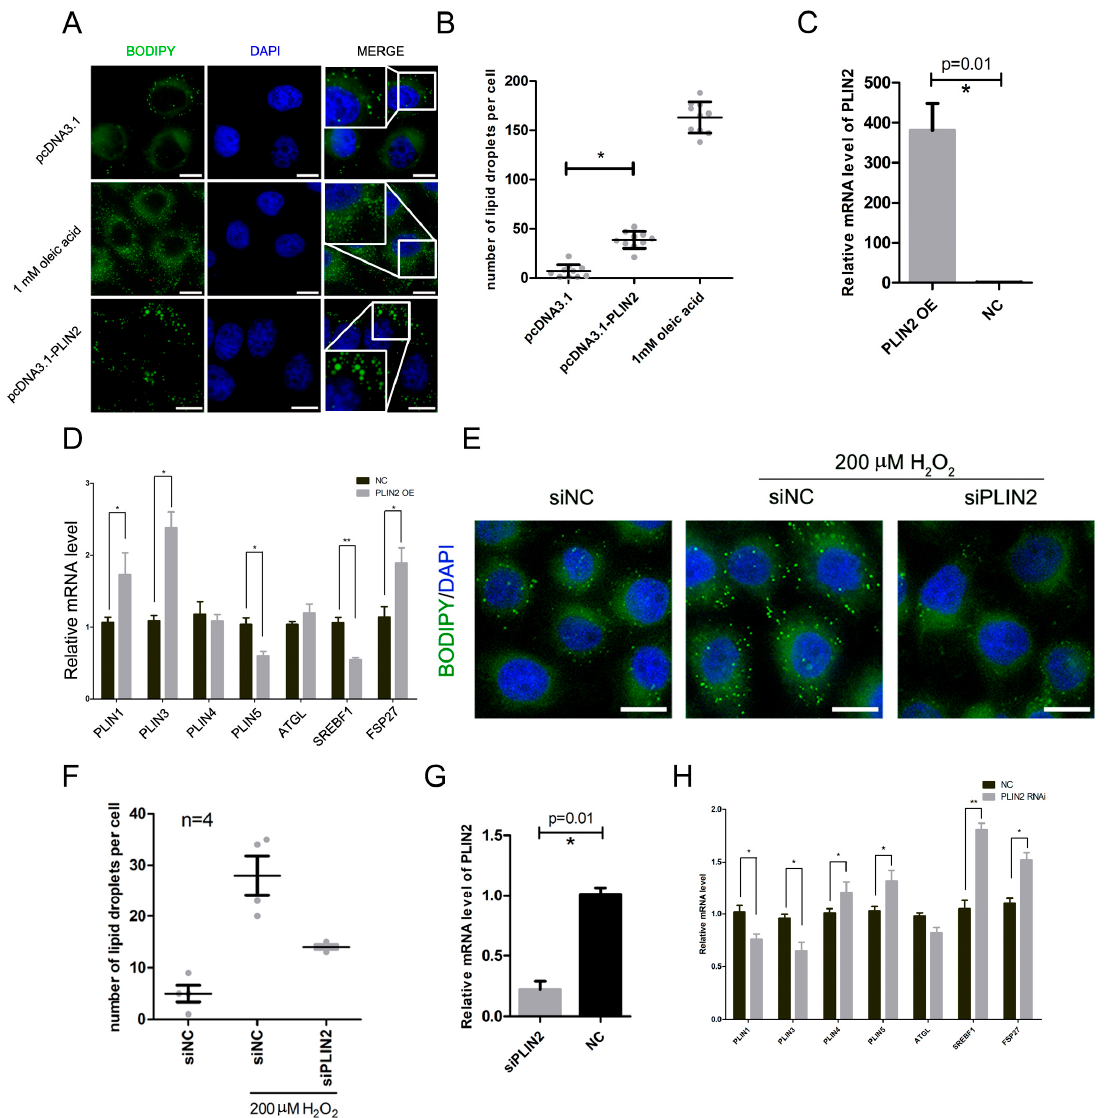
Figure 3. PLIN2 plays an important role in ROS (reactive oxygen species)-induced lipid droplet formation. ( A ) The amount of intracellular lipid droplets detected after overexpression of PLIN2. Scale bar = 10 µ m. ( B ) Statistical analysis of the number of lipid droplets. *, p < 0.05. ( C ) qRT-PCR detection of the efficiency of PLIN2 overexpression. *, p < 0.05. ( D ) Detection of lipid droplet-related gene mRNA expression levels with overexpression of PLIN2 . *, p < 0.05; **, p < 0.01. ( E ) Measurement of the amount of lipid droplets in cells treated with hydrogen peroxide after interference with PLIN2. Scale bar = 10 µ m. ( F ) Statistical analysis of lipid droplet numbers. ( G ) qRT-PCR detection of the interference efficiency of PLIN2. *, p < 0.05. ( H ) Detection of lipid droplet-related gene mRNA expression levels after interference with PLIN2 . *, p < 0.05; **, p < 0.01.